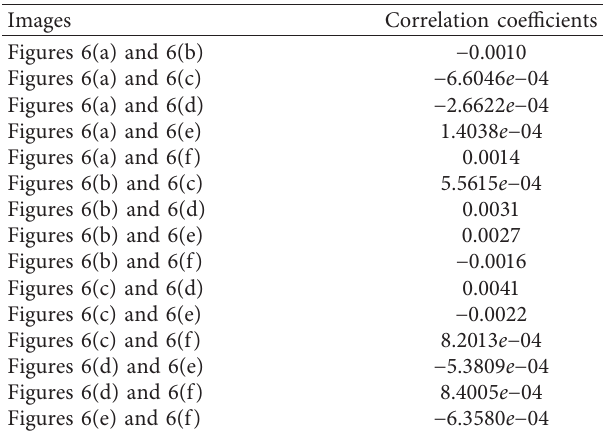
Table 7: Correlation coefficients between various cipher